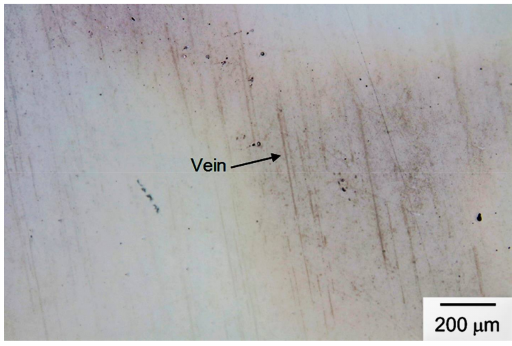
Figure 8. OM micrograph of as-received barrier film.